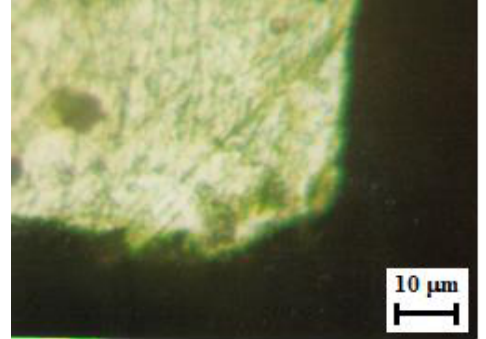
Figure 8. Cross-section image from the cutting insert.